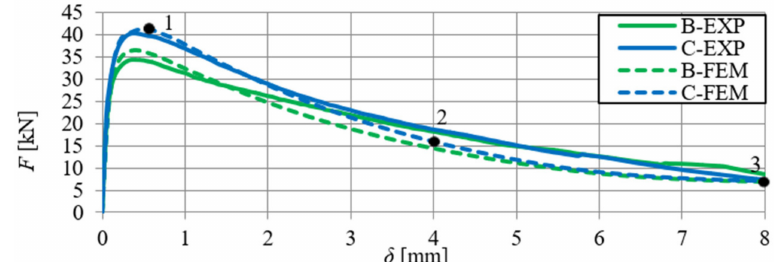
Figure 18. Comparison of numerical and experimental force–deflection relationship of SFRHSC beams in a three-point bending tests (B and C series).